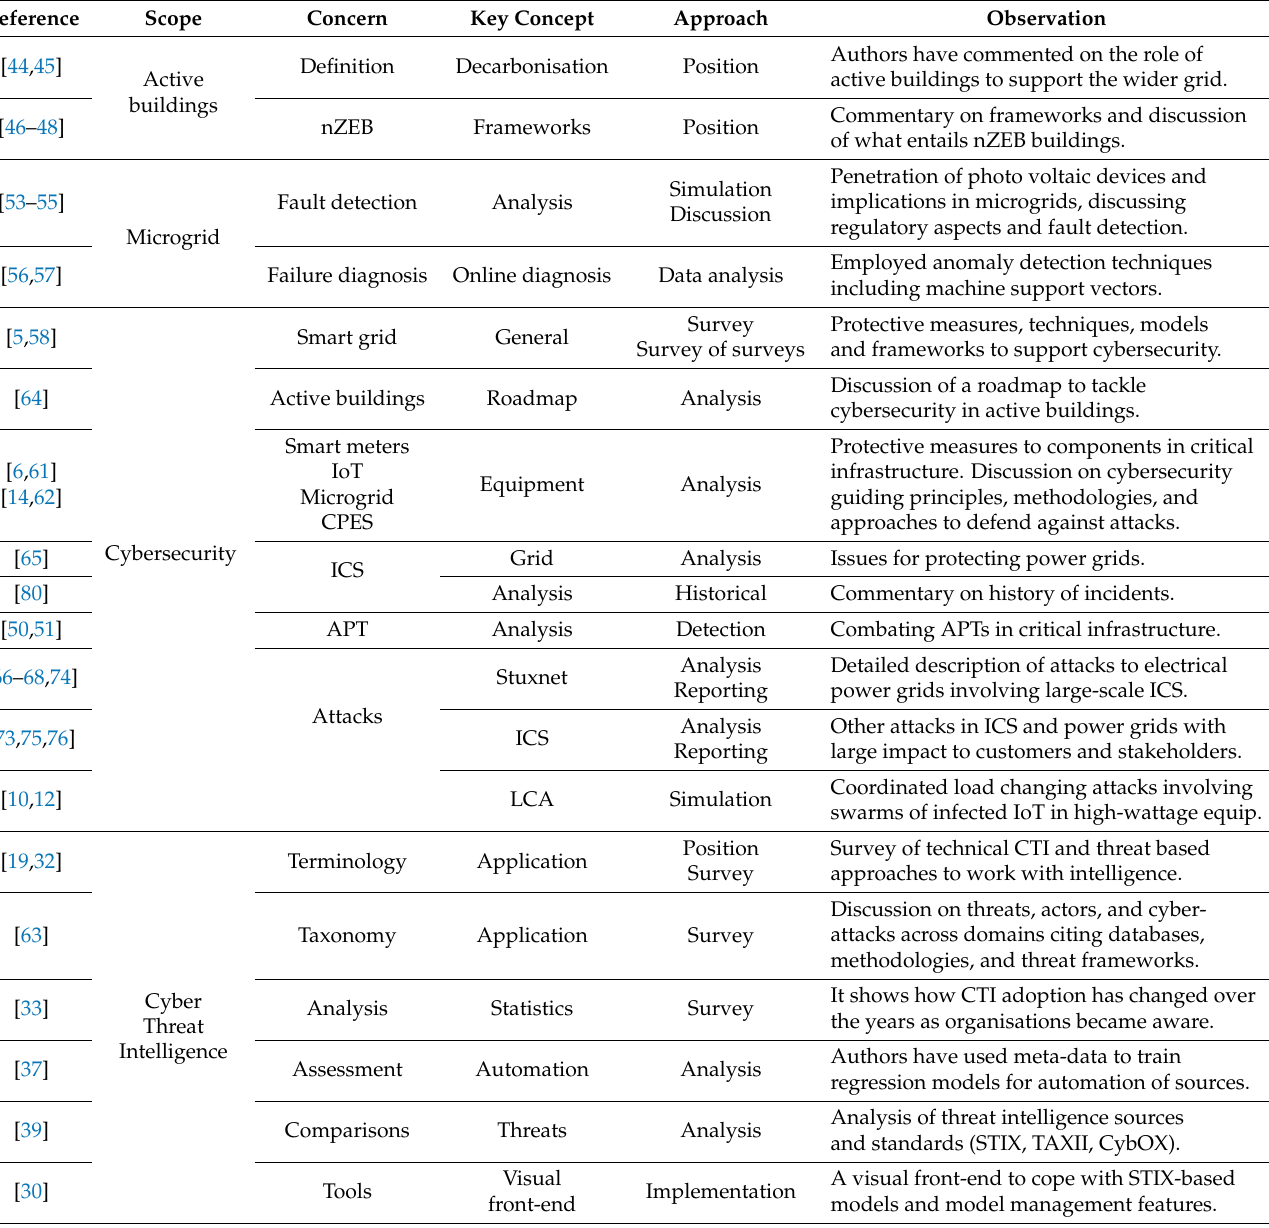
Table 1. Selected state-of-the-art of cybersecurity for leveraging CTI in CPS (including active